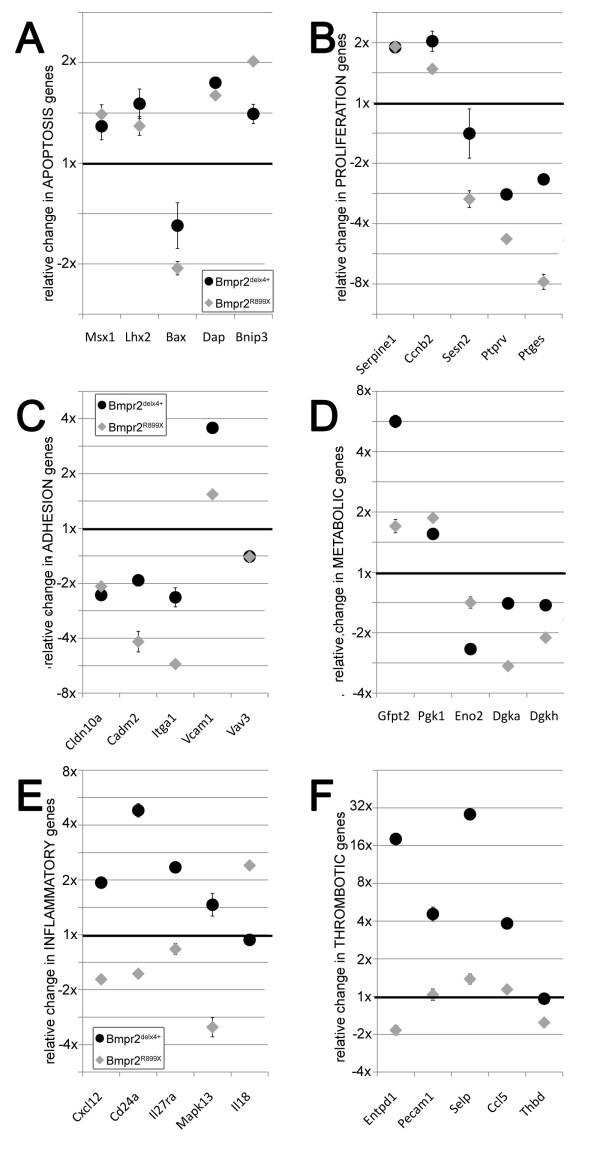
Scatter plots indicating changes in illustrative genes from different gene ontology groups in Bmpr2delx4+ (black circles) or Bmpr2R899X (grey diamonds) PMVEC. In each plot, the y-axis indicates fold change compared to control PMVEC on a log2 scale. Points falling on the 1x line are thus identical to controls; those above are upregulated, and those below are downregulated. Error bars indicate standard deviation in replicates; if they are invisible, they are smaller than the symbol (experimental replicates were very similar). Bmpr2delx4+ and Bmpr2R899X PMVEC had very similar changes in apoptosis(A), proliferation (B), adhesion (C), and metabolic (D) genes, but divergent changes in inflammatory (E) and thrombotic (F) genes.